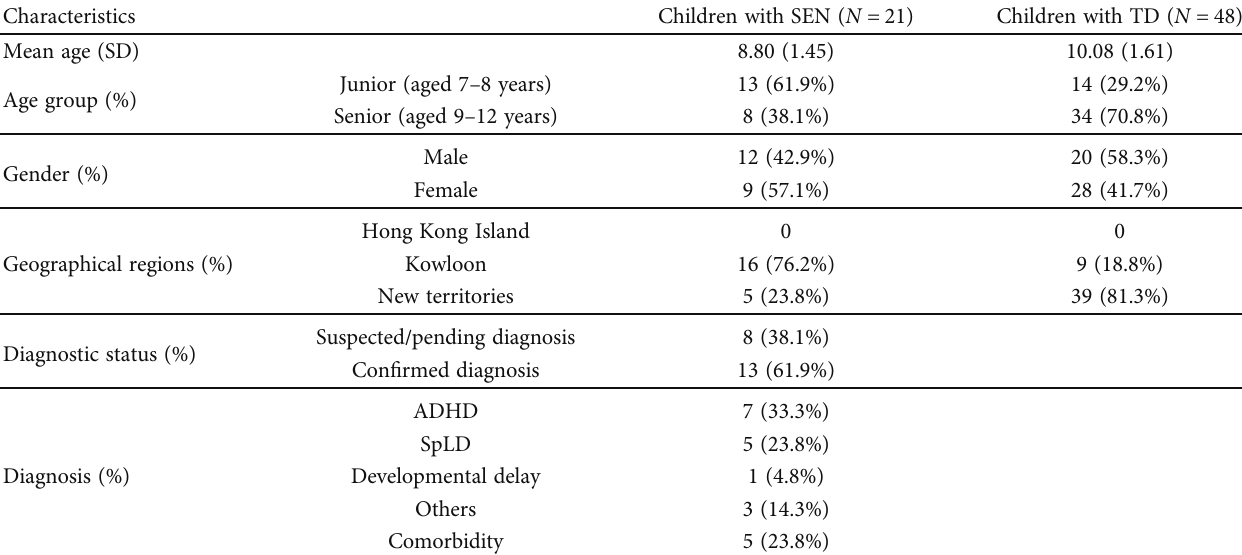
Table 1: Sociodemographic characteristics of the child participants.